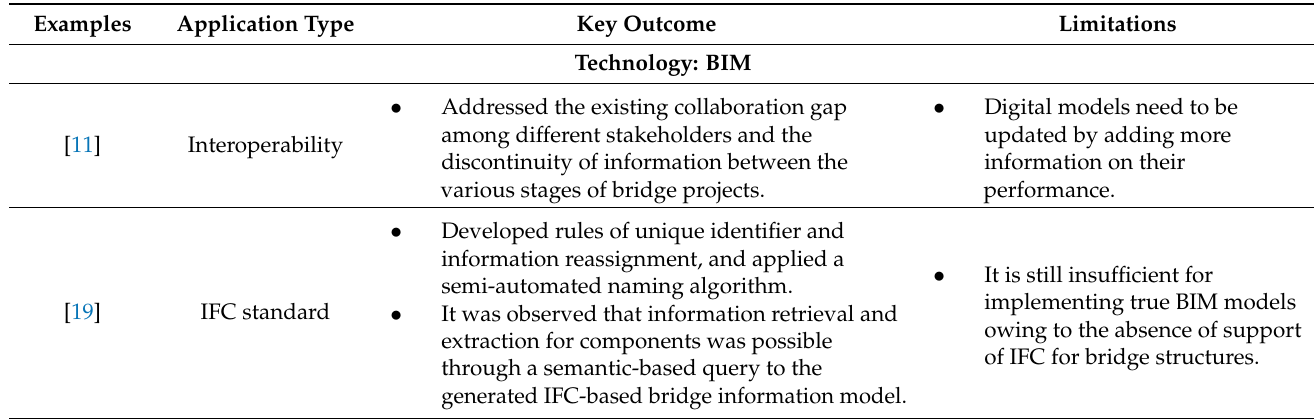
Table 6. BIM/GIS uses in information